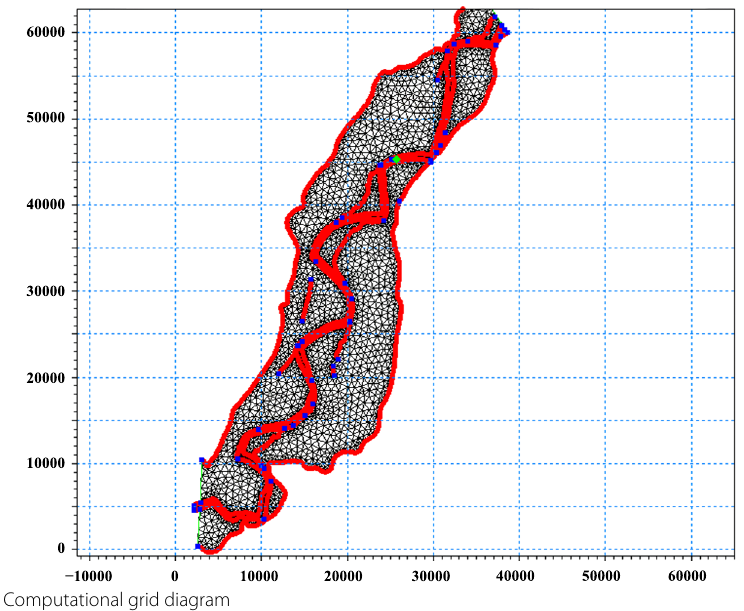
Fig. 1 Computational grid diagram